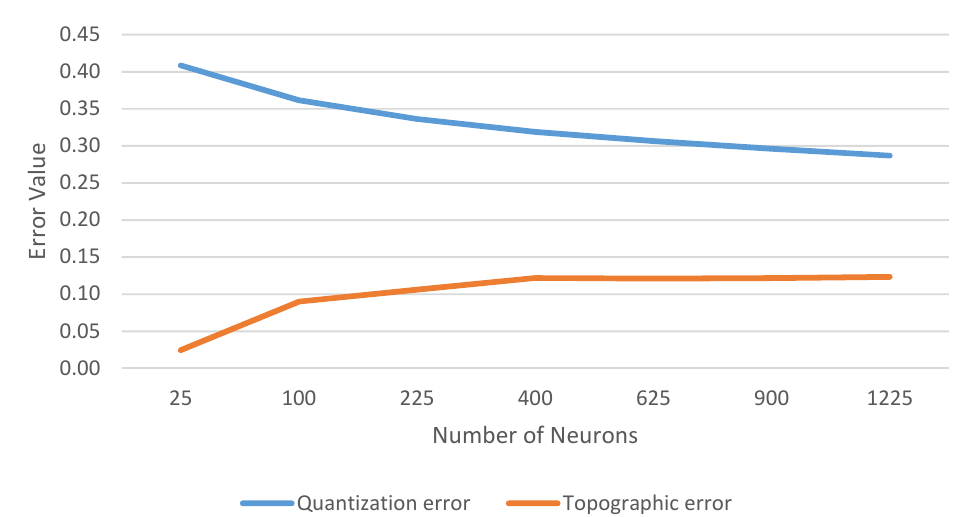
Figure 3. Comparison of quantization and topographic errors of SOMs with different numbers of